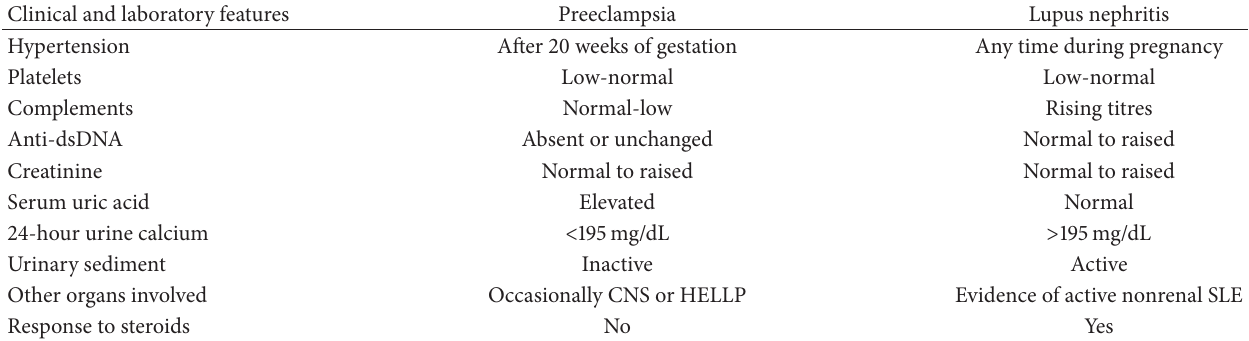
Table 3: Features differentiating preeclampsia and lupus